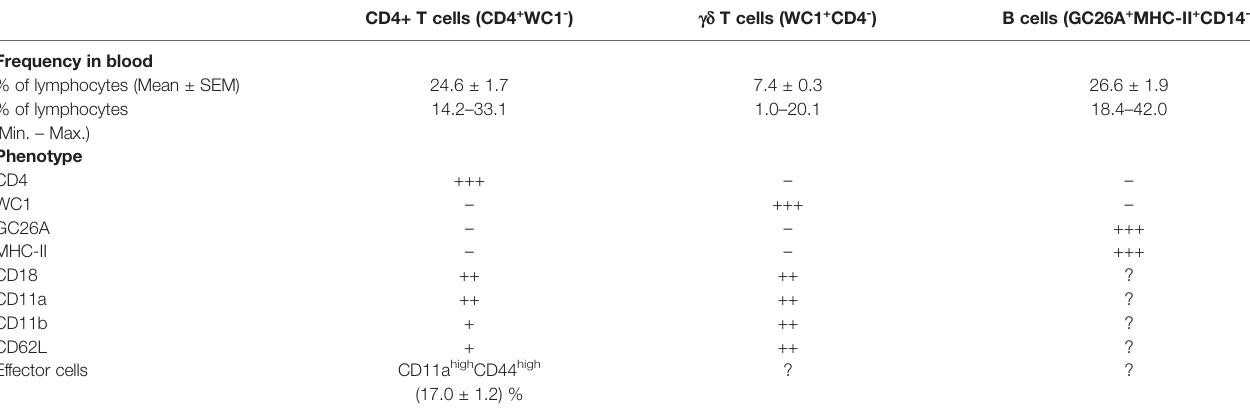
TABLE 2 | Phenotypic properties of T cells and B cells in camel